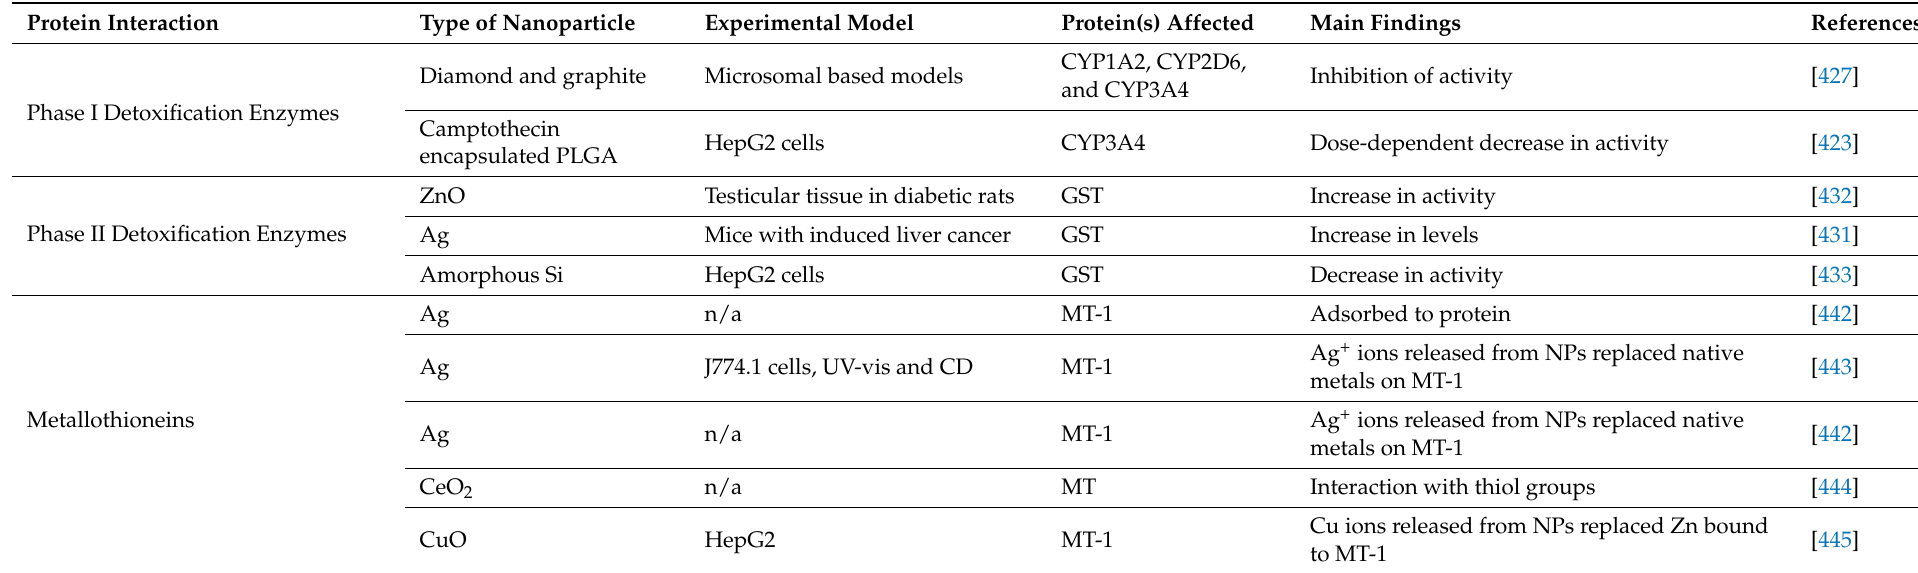
Table 8. Summary of effects of various nanoparticles on detoxification proteins in different experimental